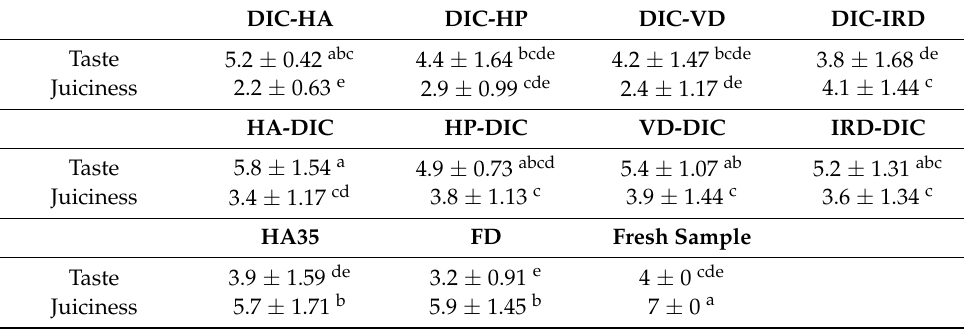
Table A2. Sensory evaluation of DIC combined drying at 65 ◦